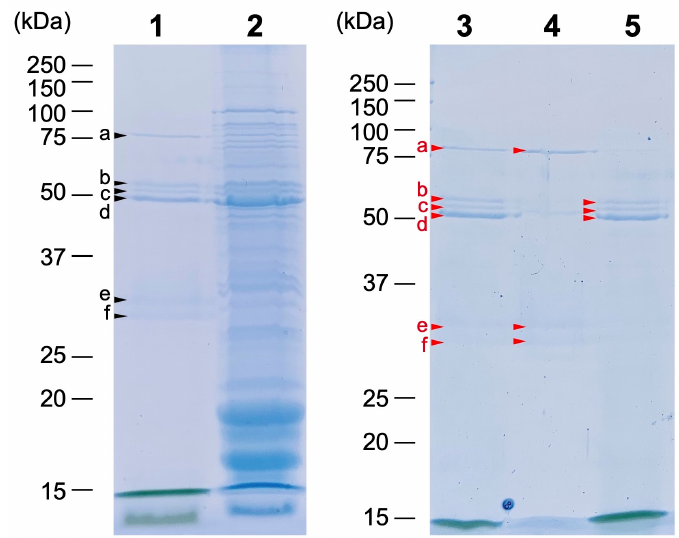
Figure 6. SDS-PAGE of Fractions 0, 1, and 2. Fractions 0 (lanes 1 and 3), 1 (lane 4), and 2 (lane 5) were analyzed using SDS-PAGE (CBB staining). The 6 major bands are indicated by arrowheads a through f, from highest to lowest molecular mass. Furthermore, the total cell extract of dark-grown YFC2 was analyzed as a reference (lane 2). The bands excised for mass spectrometric analysis are indicated by small triangles.